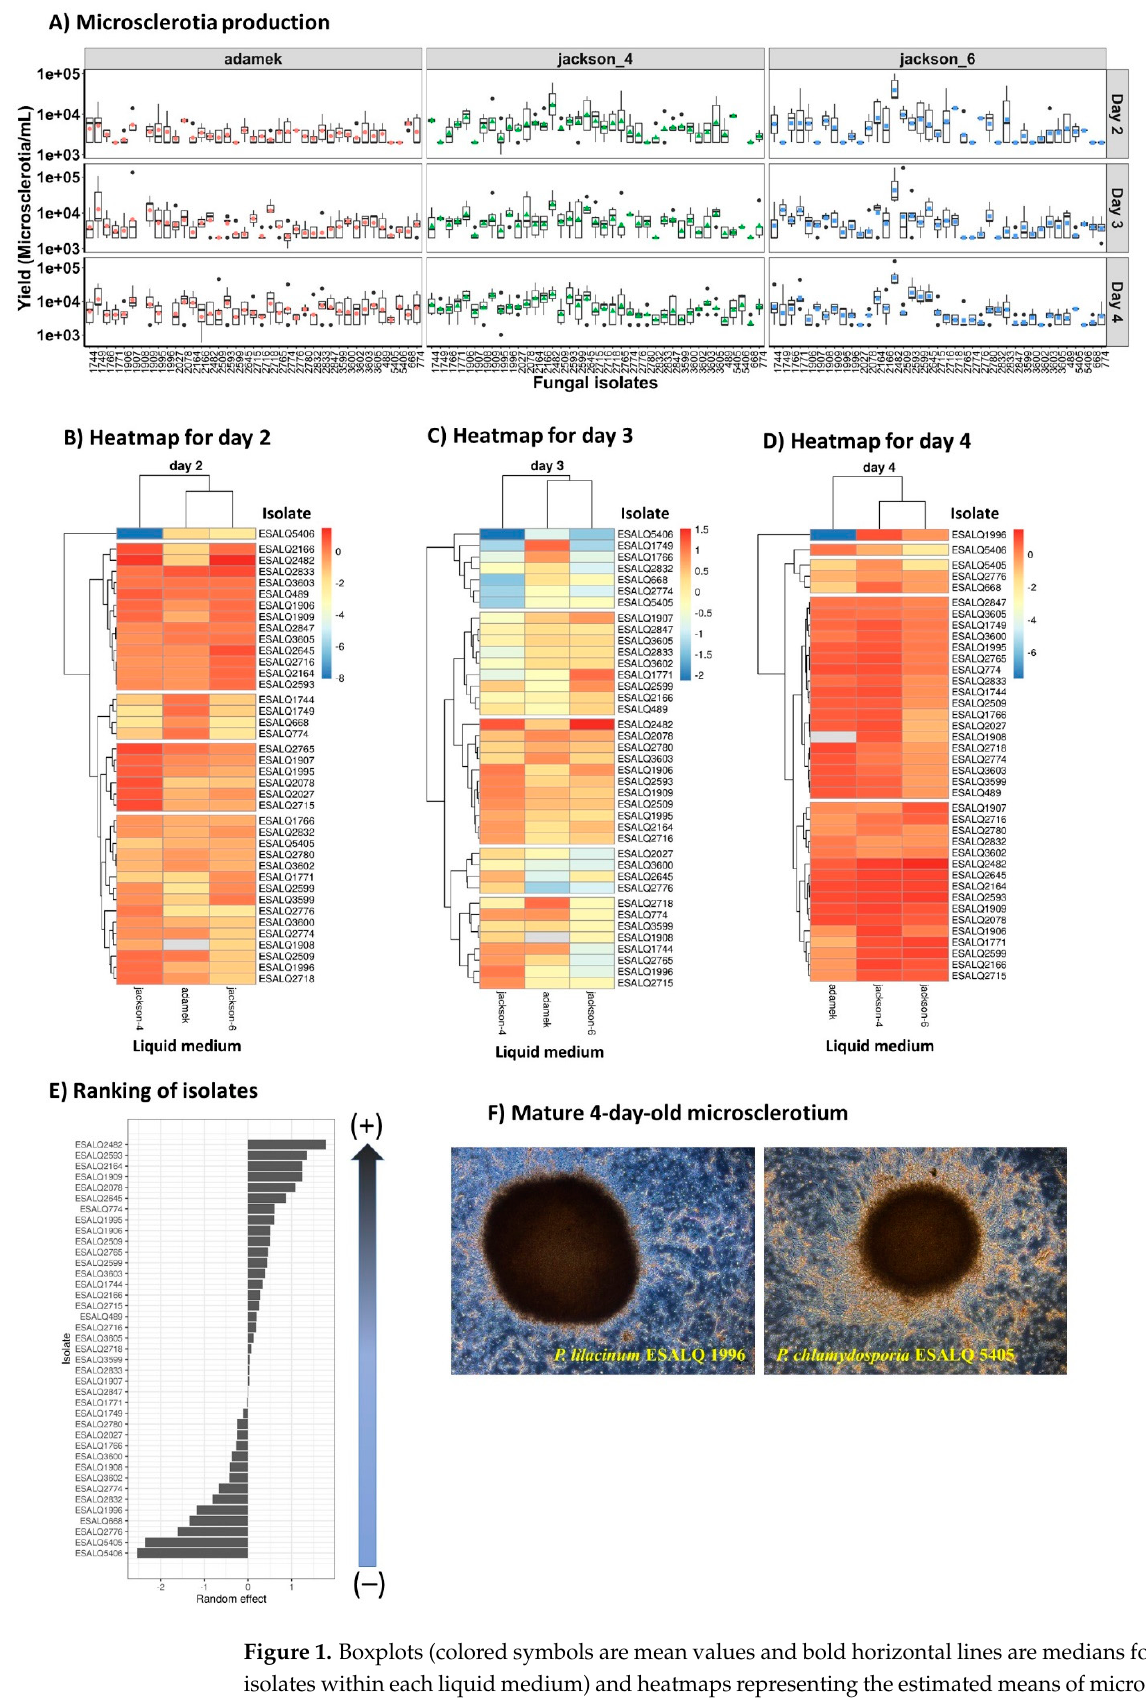
Figure 1. Boxplots (colored symbols are mean values and bold horizontal lines are medians for fungal isolates within each liquid medium) and heatmaps representing the estimated means of microsclerotia (MS) production across the 42 fungal